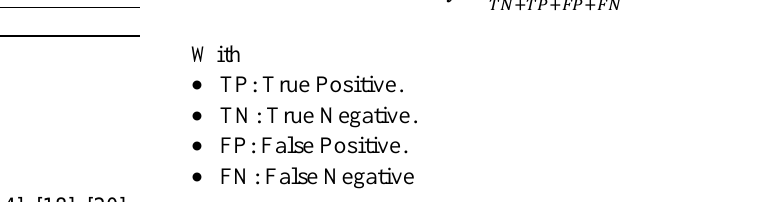
The following figure (Fig. 1) Summarize the accuracy of works using movie review data set